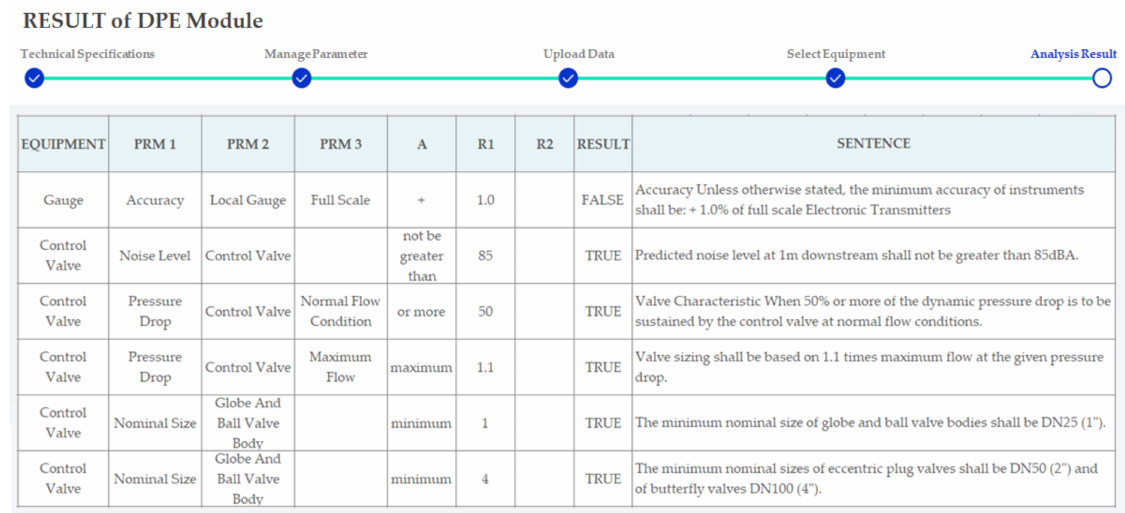
Figure 16. Result screen of the DPE